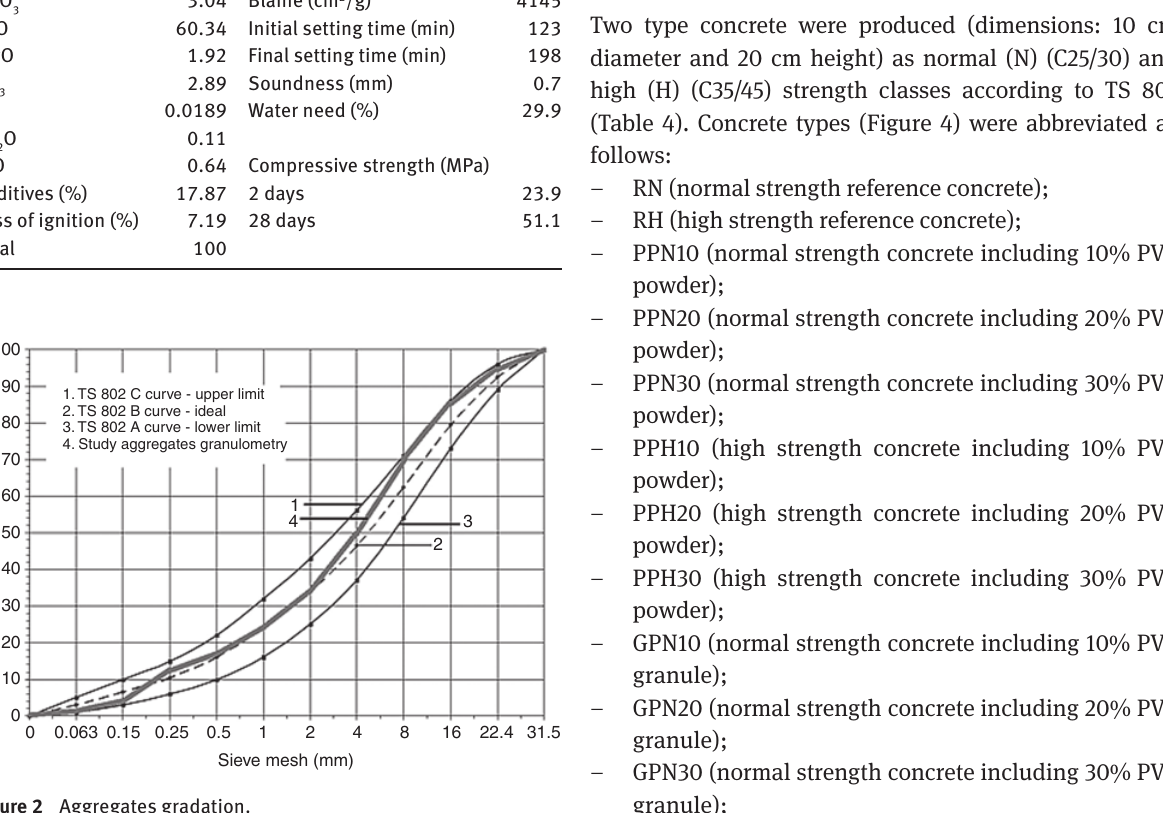
Figure 2 Aggregates gradation.